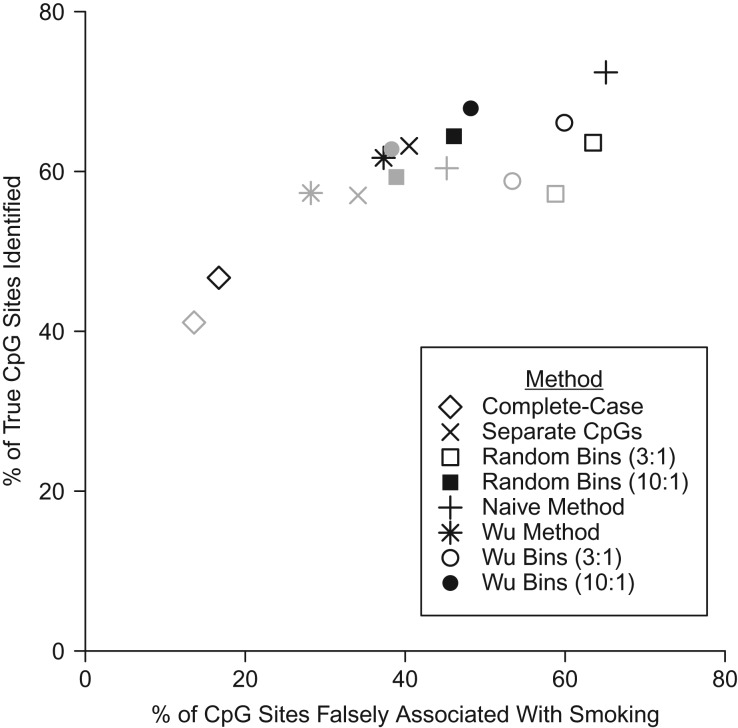
True-positive and false-positive percentages of CpG sites identified by different imputation methods in 10 repeats on the full (unreduced) data set. Values are listed in Table 2. Black symbols are for missingness mechanism 1, and gray symbols are for missingness mechanism 2.